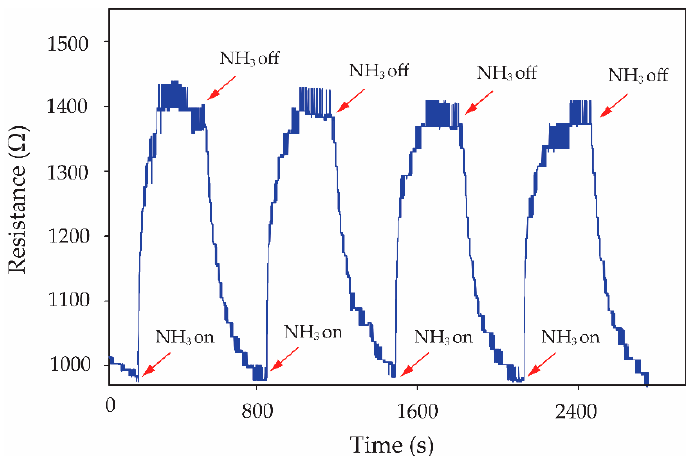
Figure 9. Resistance change of S3 gas sensor in handling repeated inlets of 80 ppm NH 3